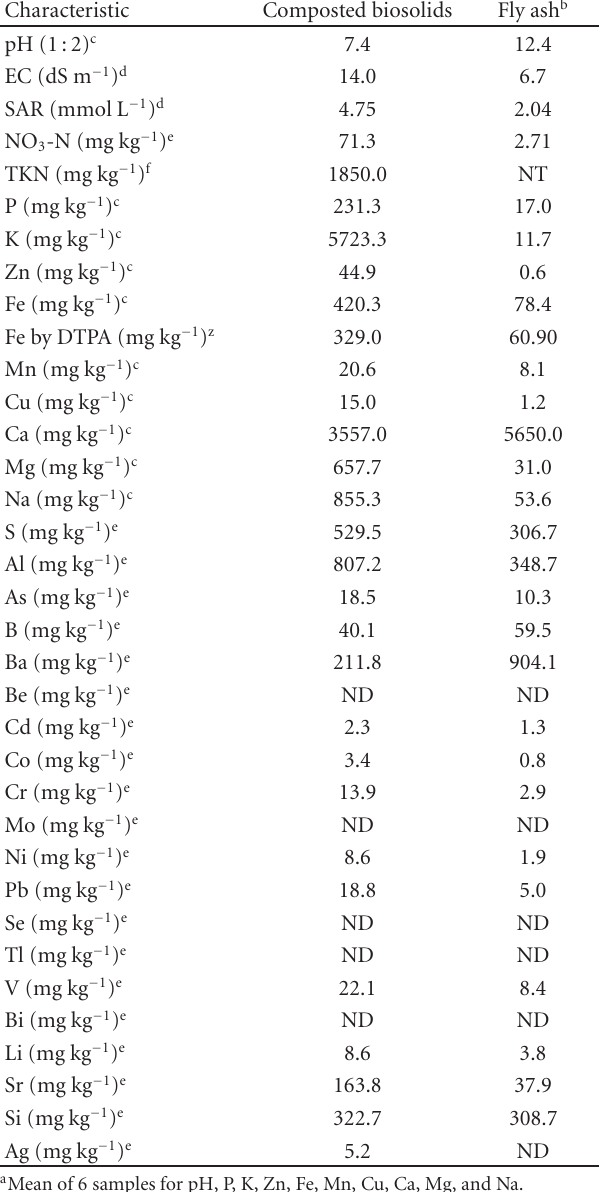
Table 1: Selected chemical properties of Albuquerque biosolids and APS fly